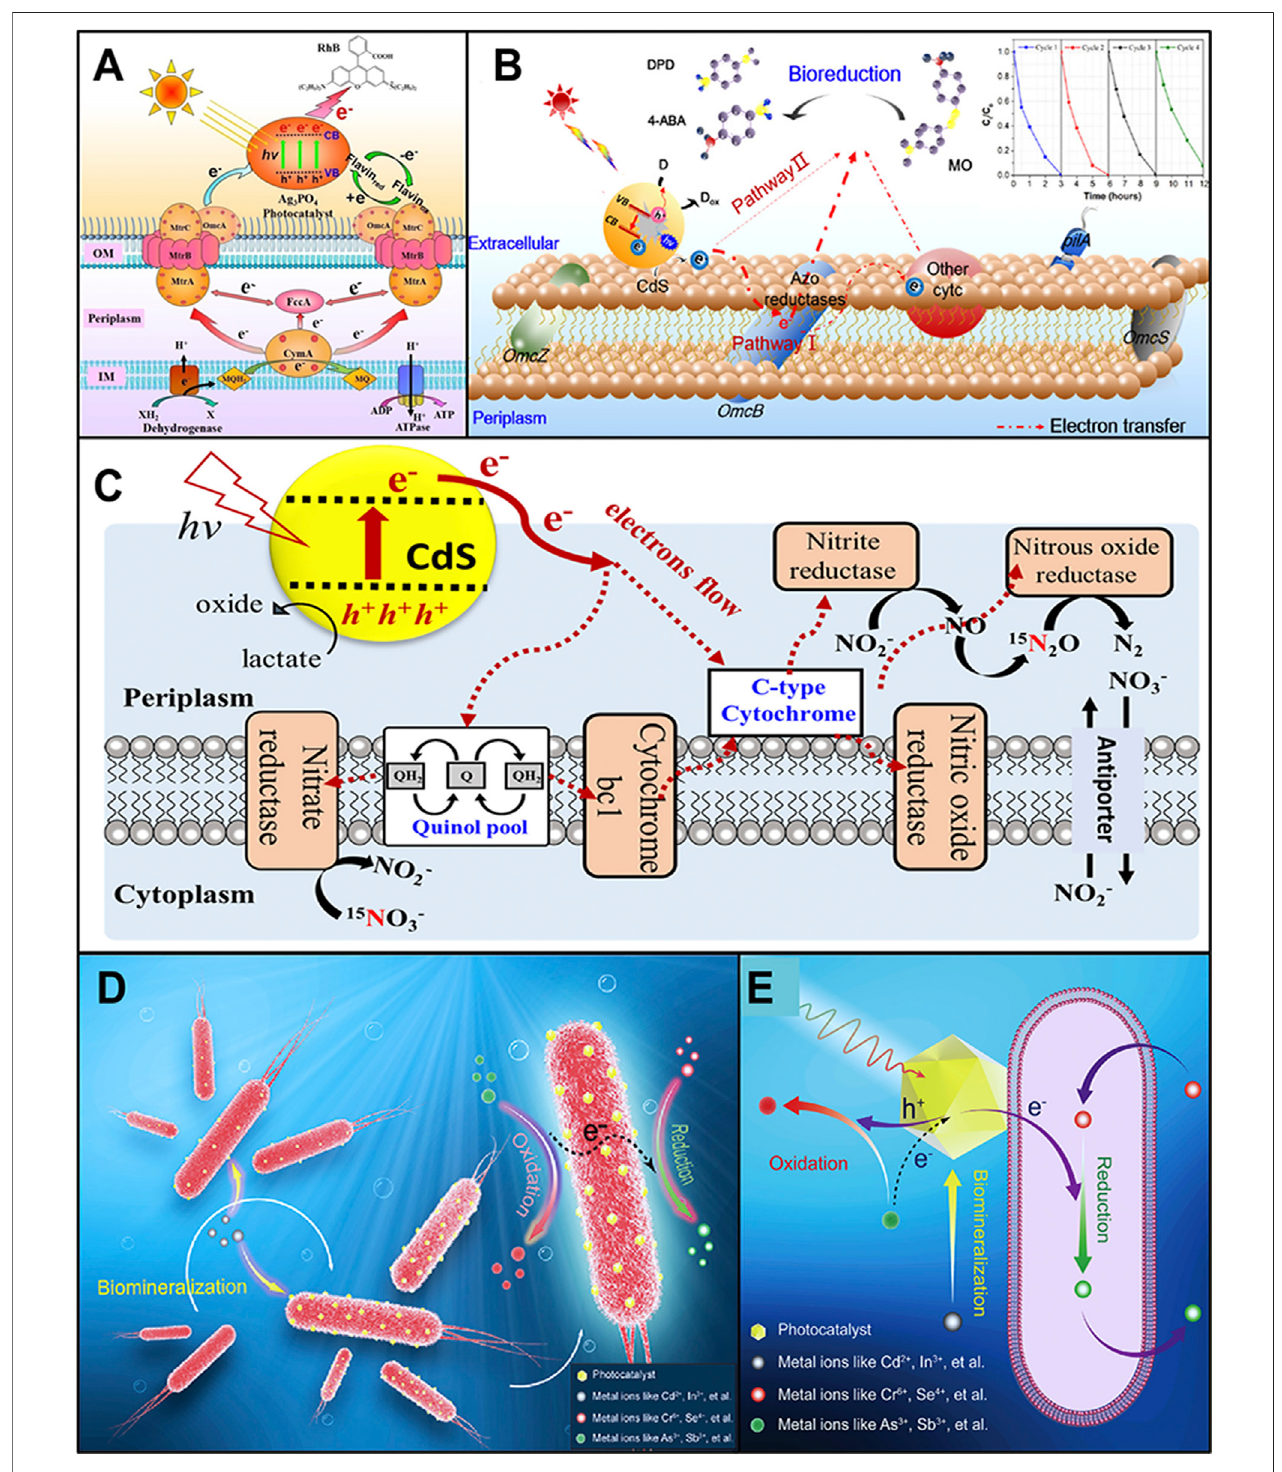
FIGURE1|(A) Schematic illustration ofthelight-driven degradation pathway ofrhodamine Busingthe Ag 3 PO 4 – S. oneidensis MR-1hybridsystem(reprinted with permission from Xiao et al., 2019). (B) Schematic illustration of the degradation pathway of MO using the CdS – G. sulfurreducens hybrid system (reprinted with permission from Huang et al., 2019). (C) Schematic illustration of the denitri fi cation mechanism in the CdS – T. denitri fi cans hybrid system driven by light (reprinted with permission from Chen et al., 2019). (D , E) Mechanism of fabricating the CdS nanomaterial – B. thuringiensis HM-311 hybrid based on the microbial mineralization ability (D) and the electron transfer between different heavy metal ions in the hybrid system (E) (reprinted with permission from Zuo et al., 2021a).